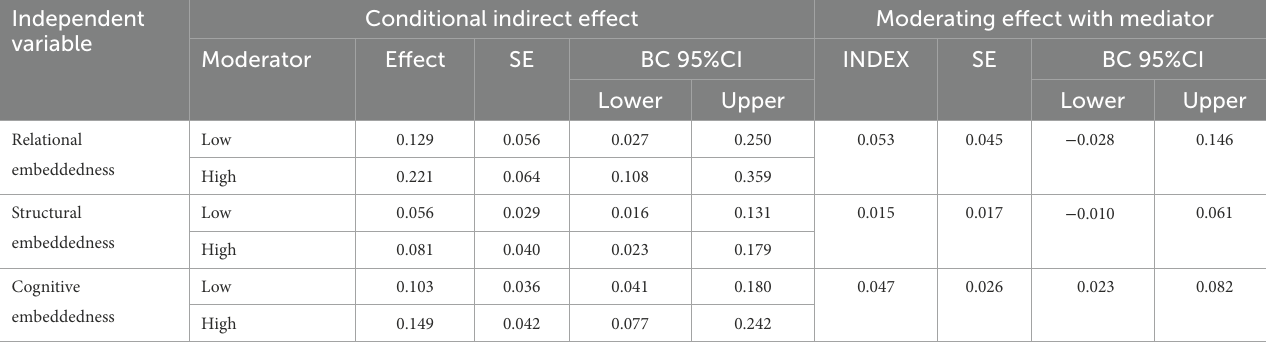
TABLE 6 Robustness test of moderating